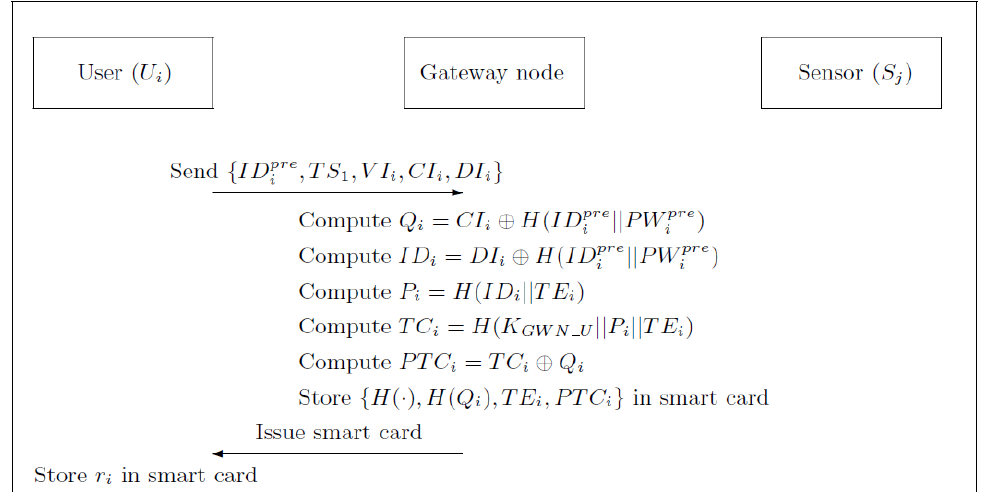
Figure 3. Illustration of the login phase of our advanced